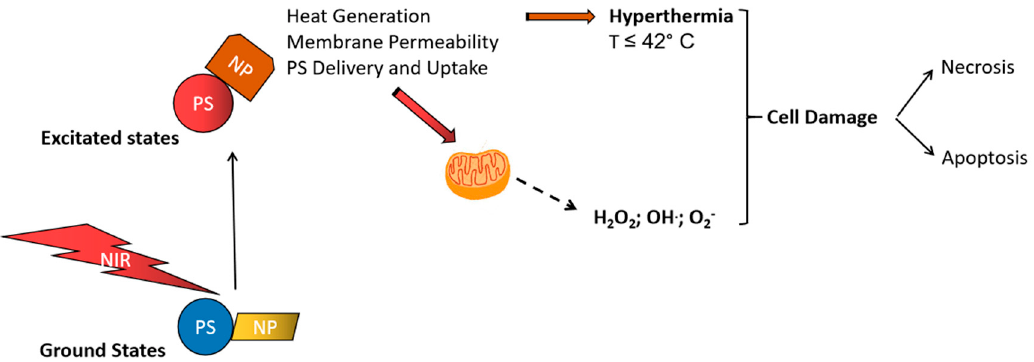
Figure 3. In combination therapy, both photodynamic and photothermal therapy (PTT) and photodynamic therapy (PDT) agents are irradiated and excited to an upper electronic level, where the PTT agent generates heat that facilitates cell membrane permeability and more PDT agent release and uptake into tumor tissue. Hyperthermia and free radical generation cause ablation and tumor damage and killing through necrosis and/or apoptosis. PS: photosensitizing molecule, NP: nanoparticle; NIR: near-infrared